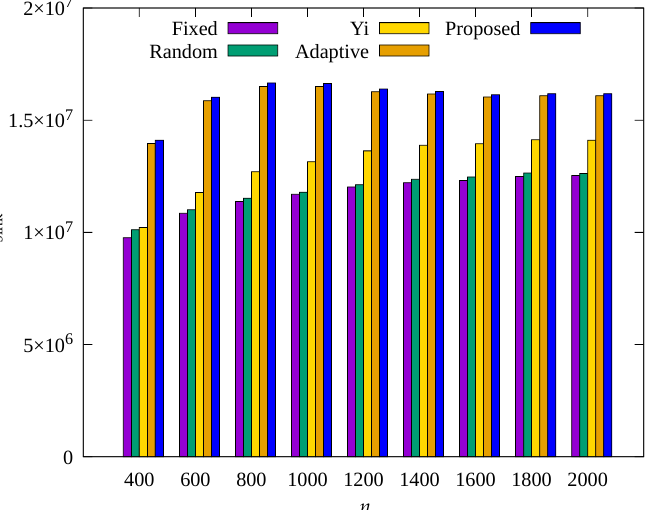
Figure 13. Comparison of the number of data gathered according to the number of